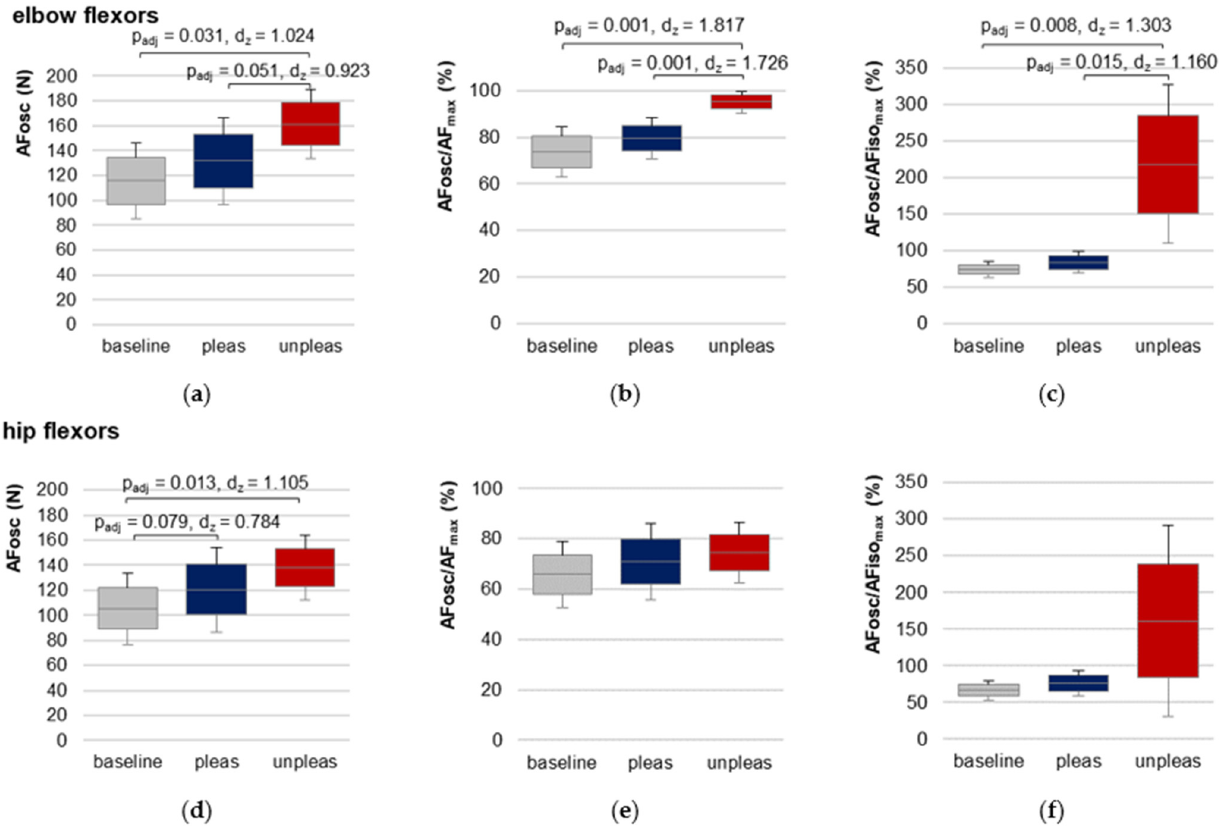
Figure 6. Adaptive Force at the onset of oscillations. Arithmetic means, standard deviations (error bars) and 95% CIs of the AF at the onset of oscillations (AFosc (N); ( a , d )) and the ratios AFosc to AF max (%) ( b , e ) and to AFiso max (%) ( c , f ) compared between baseline (grey), pleasant (pleas, blue) and unpleasant (unpleas, red) imagery for elbow flexors ( a – c ) and hip flexors ( d – f ) are displayed. Adjusted p values (Bonferroni correction) and effect sizes Cohen’s d z are given in case of signifi- cance.